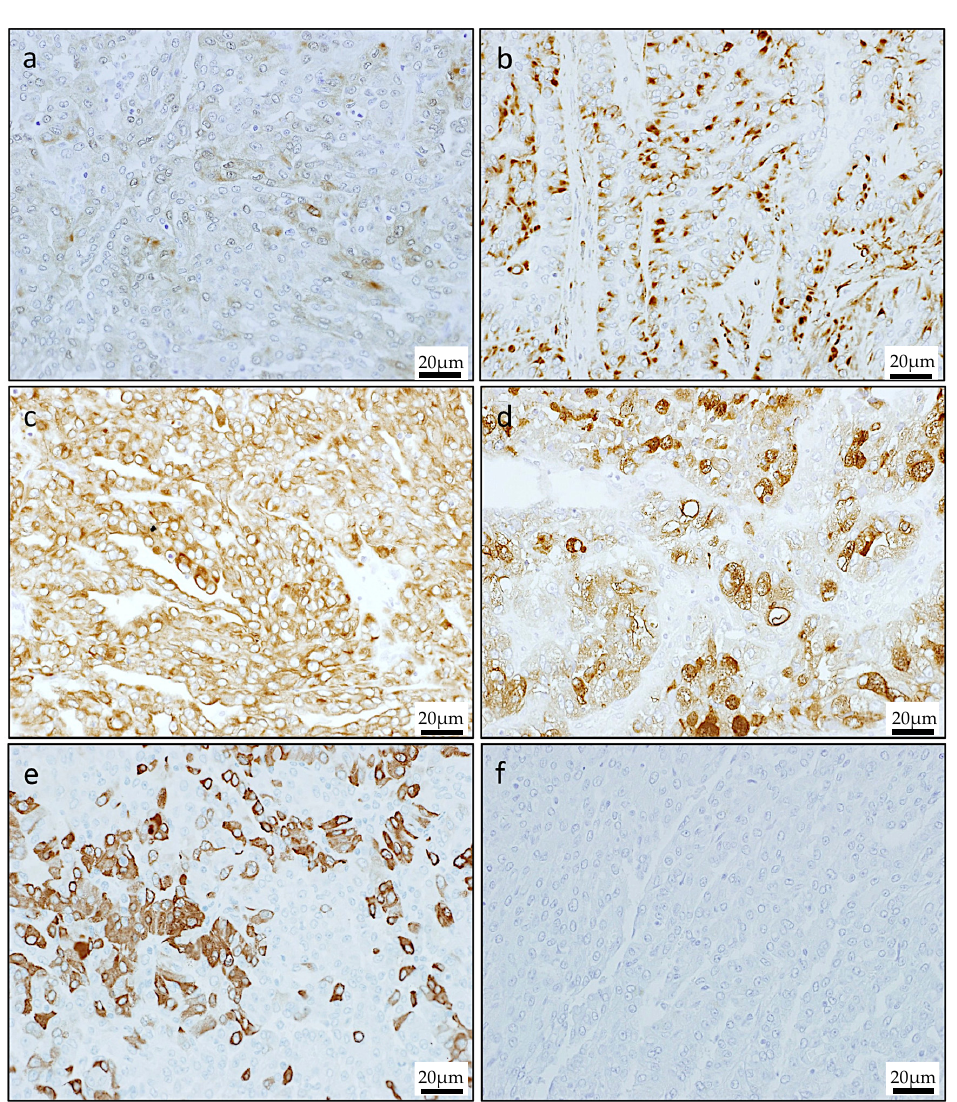
Figure 4. Immunohistochemical staining of the primary lesion. The cells were strongly positive for S-100 ( a ), vimentin ( b ), AE1/3 ( c ), epithelial membrane antigen (EMA) ( d ), and mammaglobin ( e ), but negative for GCDFP-15 ( f ).